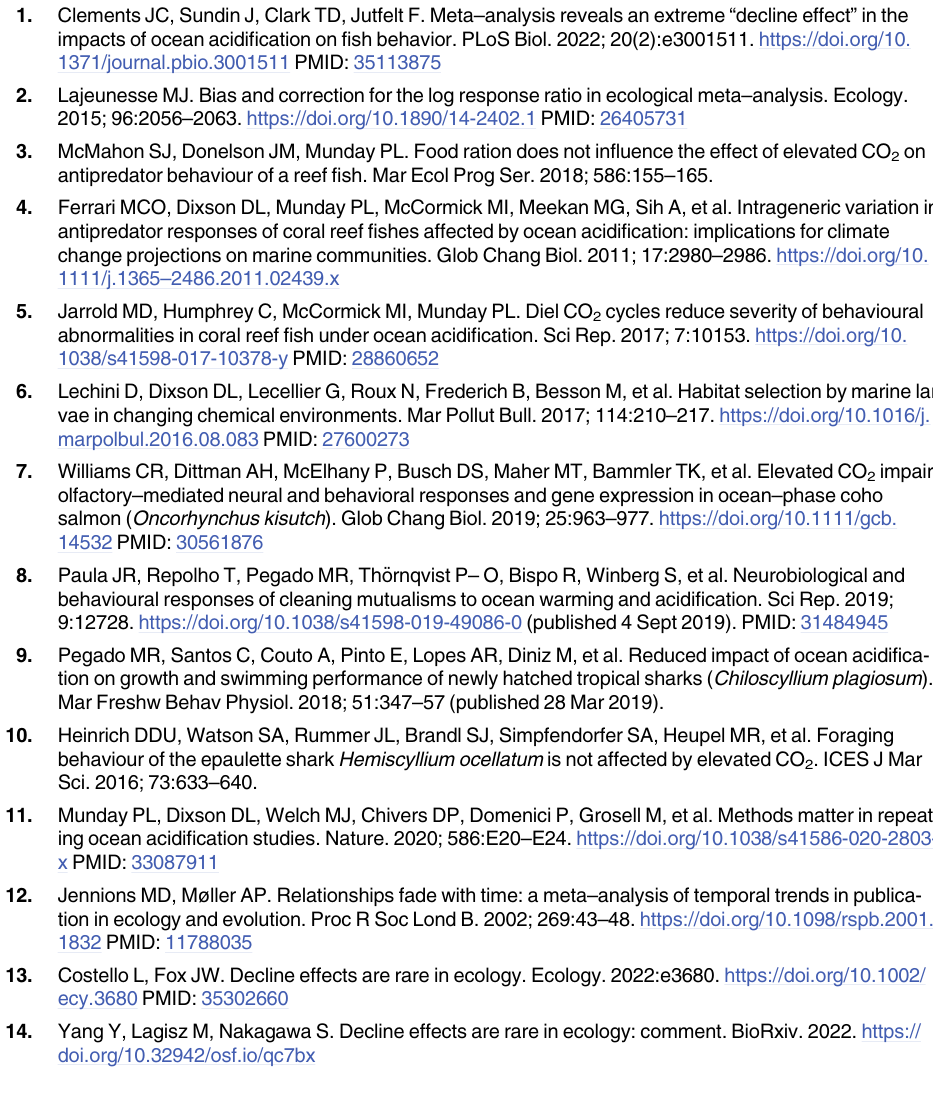
S1 Data. Data associated with Fig 1E. Calculated lnRR for control values ranging from 0.0001%–5% for treatment values of 50% and